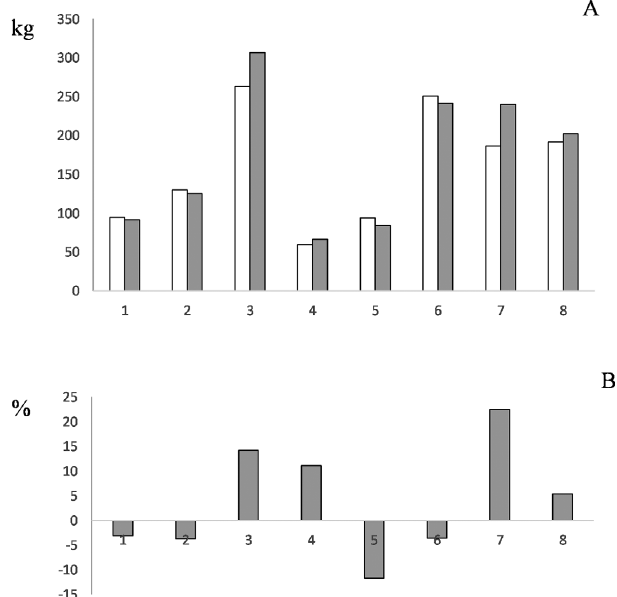
Figure 1. (A) Total milk yield at the end of lactation (kg) per fl ock and group; control (white) and treated (grey) groups. (B) Increase in milk production in the treatment group with respect to the control